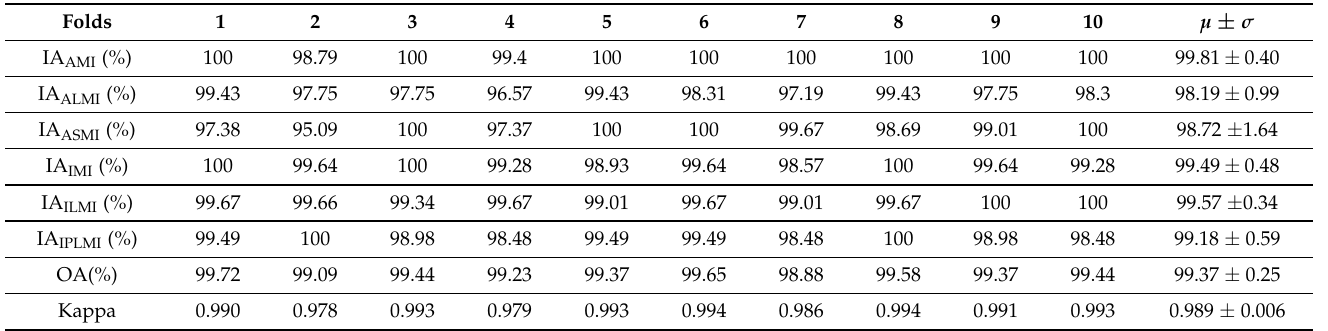
The classification results of MMDCNN models evaluated using the selected modes of each lead VCG signal, and all modes of high-pass filtered VCG signals for MI detection with hold-out validation are shown in Table 9. It is observed that the average accuracy value of MMDCNN is 99.58% using mode 1 and mode 2 of each lead VCG signal. The average accuracy value remains Mode 1 and mode 2 capture the significant information of the VCG signal after decomposition using MVMD. Henceforth, the accuracy value remains the same for MI detection using selected modes and the MMDCNN classifier. Moreover, we have also evaluated the classification performance of the MMDCNN model using all modes of high-pass filtered VCG signal for MI detection. A high-pass Butterworth filter with a cut-off frequency of 0.5 Hz is applied to each lead VCG signal to remove baseline wondering artifacts [6,28]. It is observed from Table 9 that average accuracy, average kappa score, average sensitivity, and average specificity values are improved after the filtering of baseline wandering artifact from VCG signals. In Table 10, we have shown the individual accuracy value for each MI class, OA, and kappa scores of MMDCNN classifier for MI localization using mode 1 and mode 2 of each lead VCG signal and all modes of high-pass filtered VCG signals,